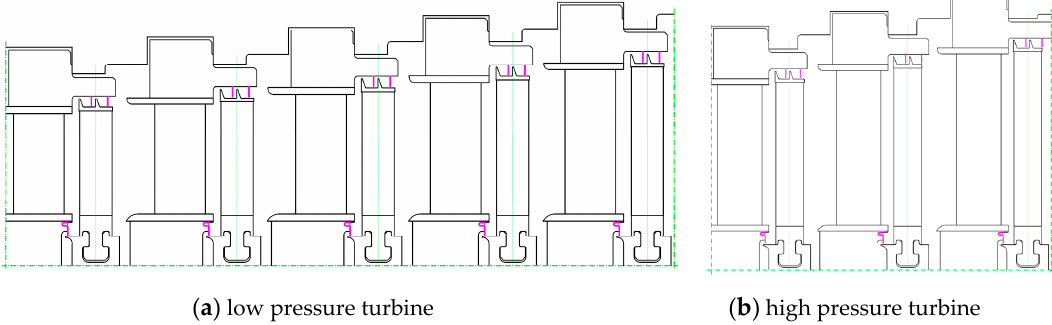
Figure 15. Flow part of high (a) and low pressure (b) turbine for Variant 8 and MM working fluid.